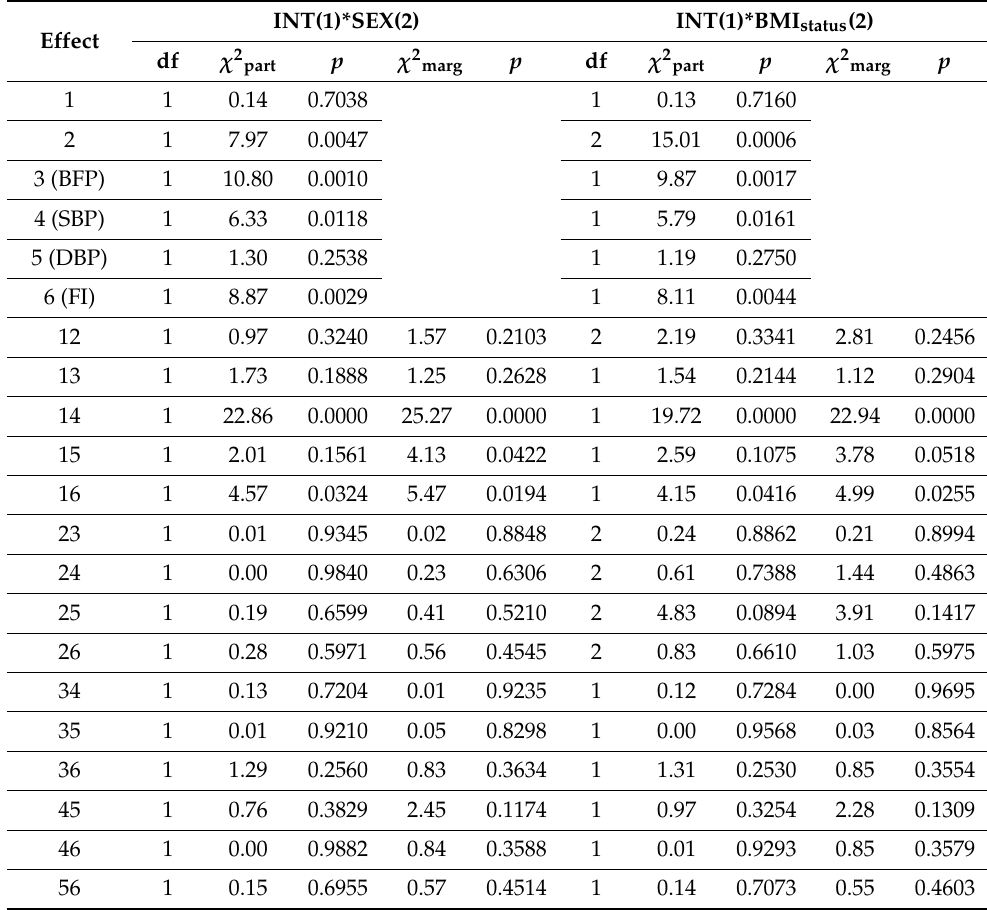
Table 4. Results of the partial ( χ 2 part) and marginal ( χ 2 marg) tests between the factors (1*2) and dependent variables (BFP, SBP, DBP, and FI): main effects and interactions (only selected interactions are presented).